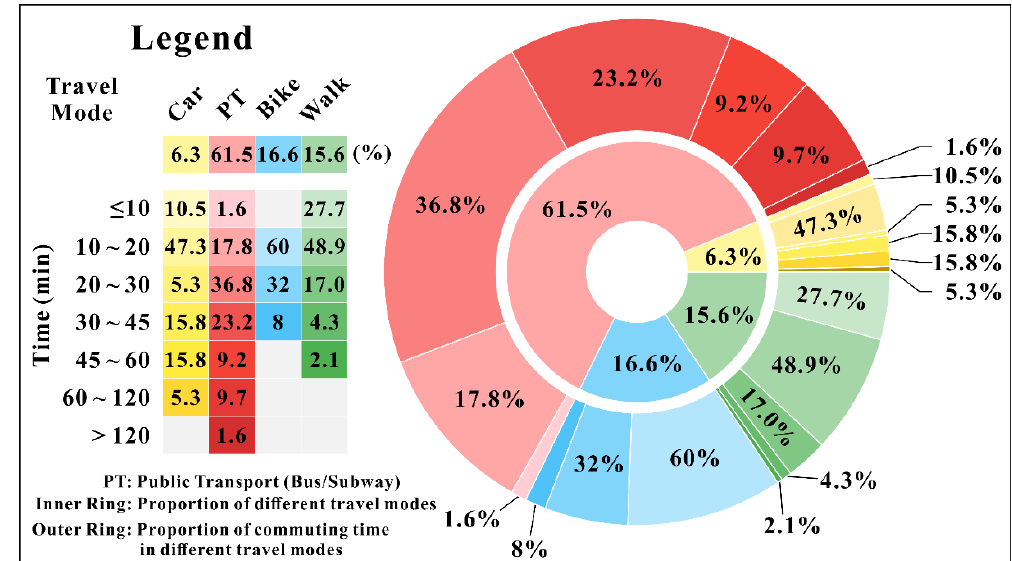
Figure 4. The proportions of travel modes and commuting times of high school students in Wuhan.